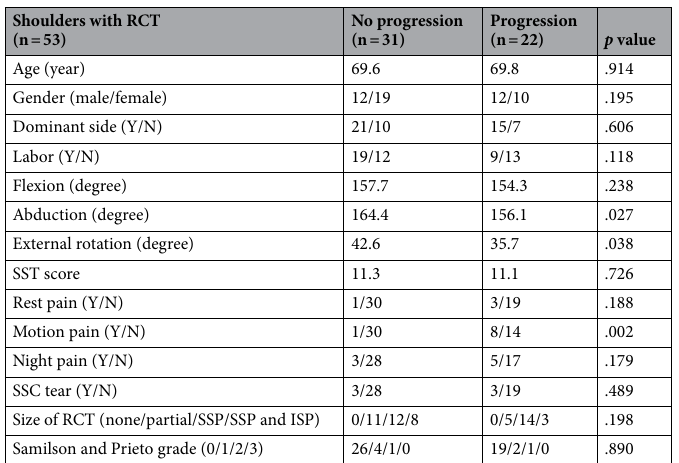
Table 5. Comparison of parameters in 2012 between the No progression group and the Progression